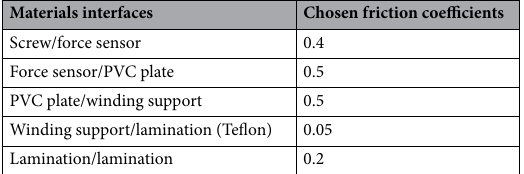
Table 3. Chosen friction coefficients for mechanical FE